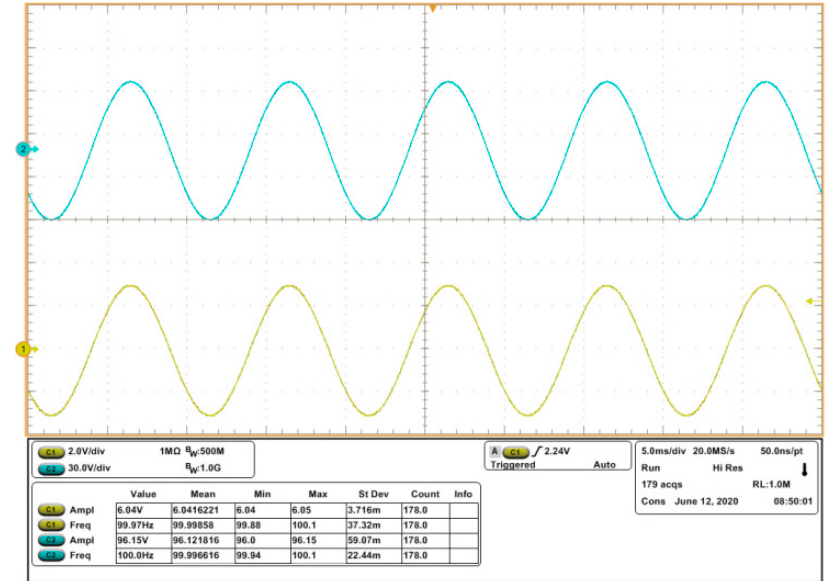
Figure 21. Measured waveforms of input (c1) and output (c2), as the input sinusoidal wave has an amplitude of 6 V and frequency of 100 Hz.